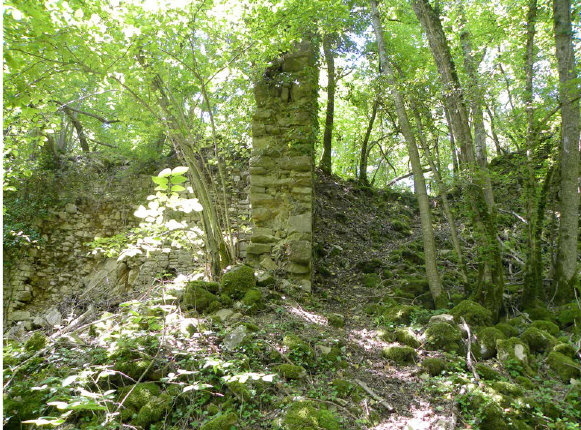
Figure 2. The sample area at Monfaucon. More vegetation was present at the time of ALS data collection.